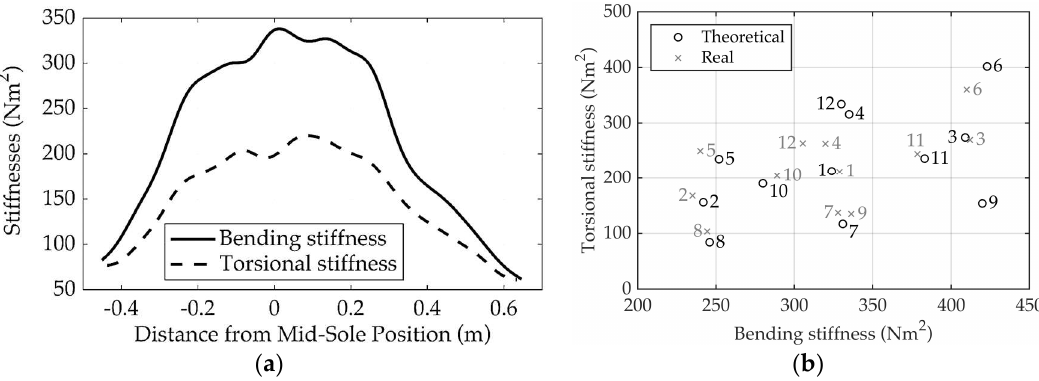
Figure 1. ( a ) Distribution of ski bending and torsional stiffness; ( b ) Maximum bending and torsional stiffness of the twelves pairs of